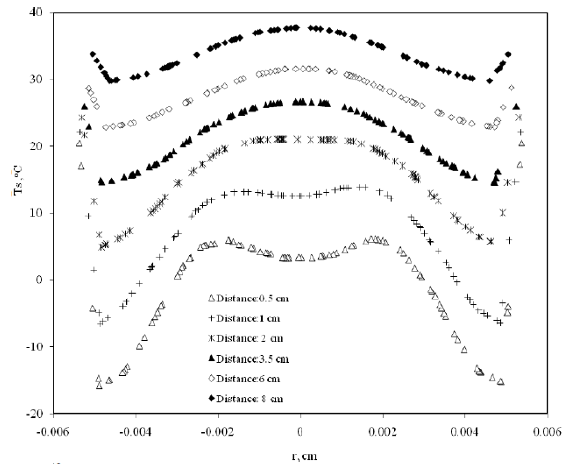
Figure 17. Variation of velocity magnitude at different location at axial cross section of vortex tube.